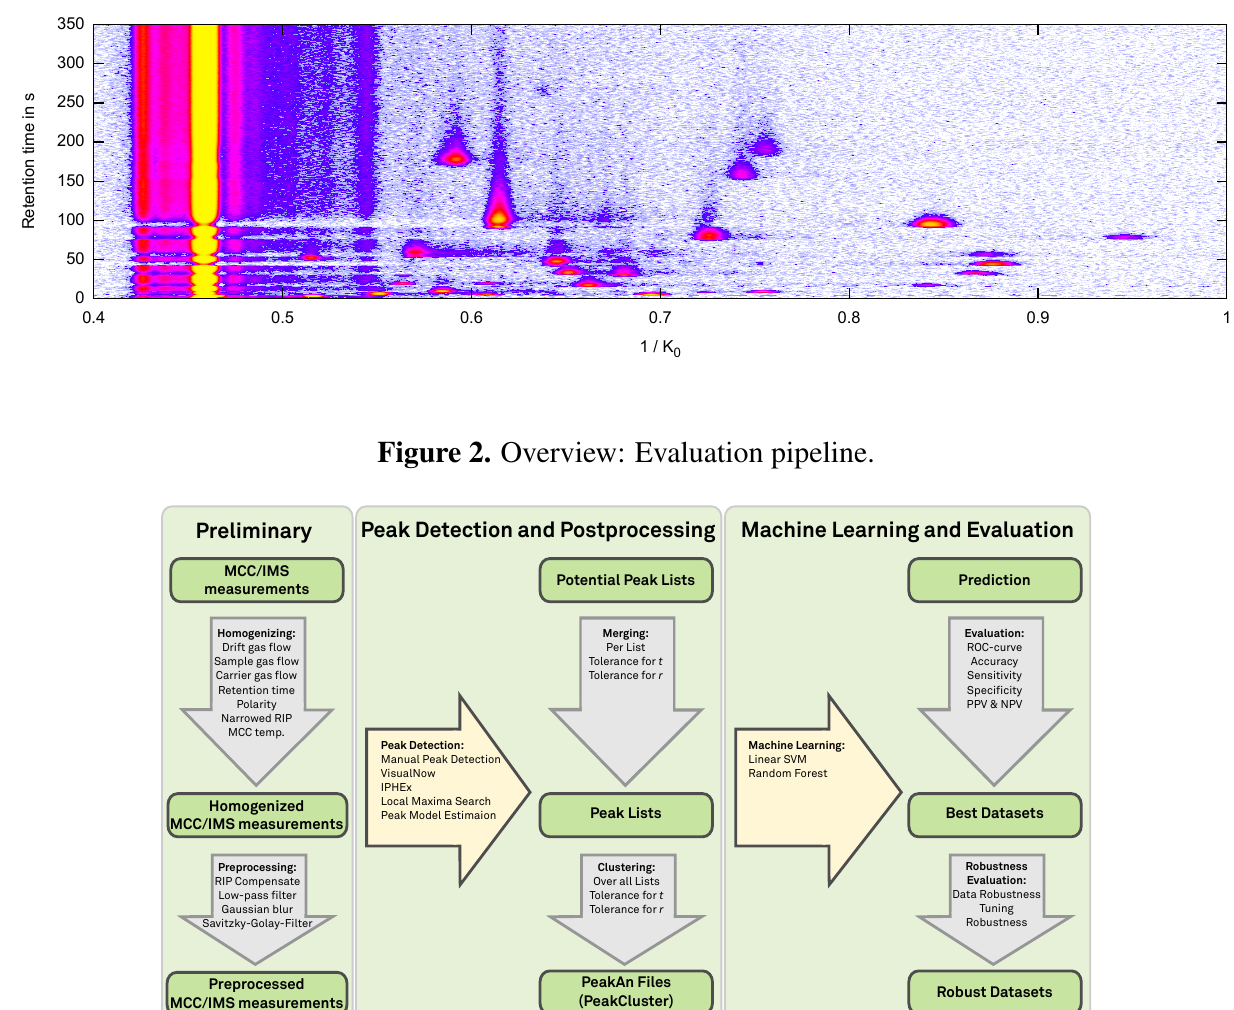
0 = 0 . 46 Vs / cm 2 . 0